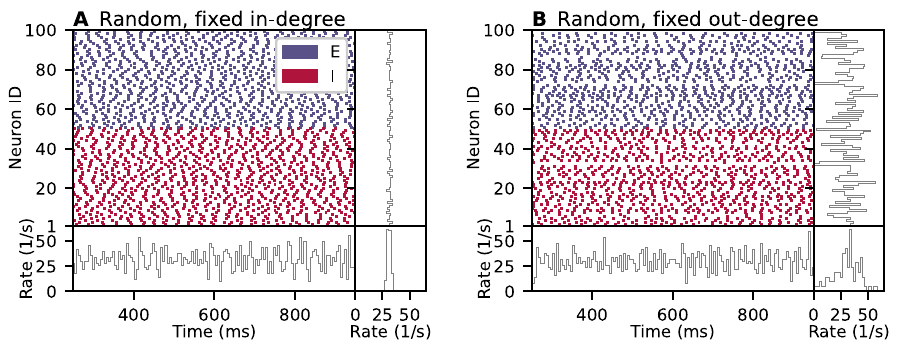
Fig 1. Spiking neuron network simulations of a balanced random network with (A) fixed in-degree and (B) fixed out-degree. Top left: Raster plots show spike times of 50 out of 10, 000 excitatory (E) and 50 out of 2, 500 inhibitory (I) neurons. Bottom left: Time-resolved spike rate from spike-count histogram across time with temporal bin width of 5 ms. Top right: Per-neuron spike rate from spike-count histogram for individual neurons. Bottom right: Normalized distribution of per-neuron spike rates with bin width of 2/s. Model details are given in Section “Materials and methods”.